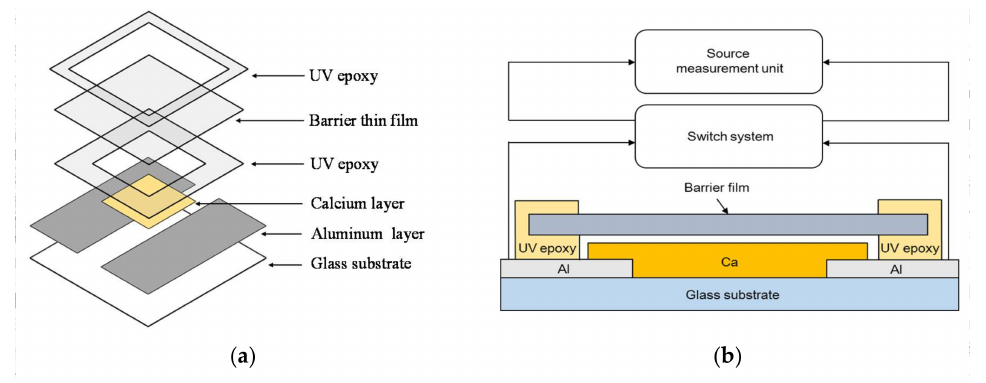
Figure 3. Schematic diagram of WVTR measurement: ( a ) exploded view of Ca test layout; ( b ) experimental setup.